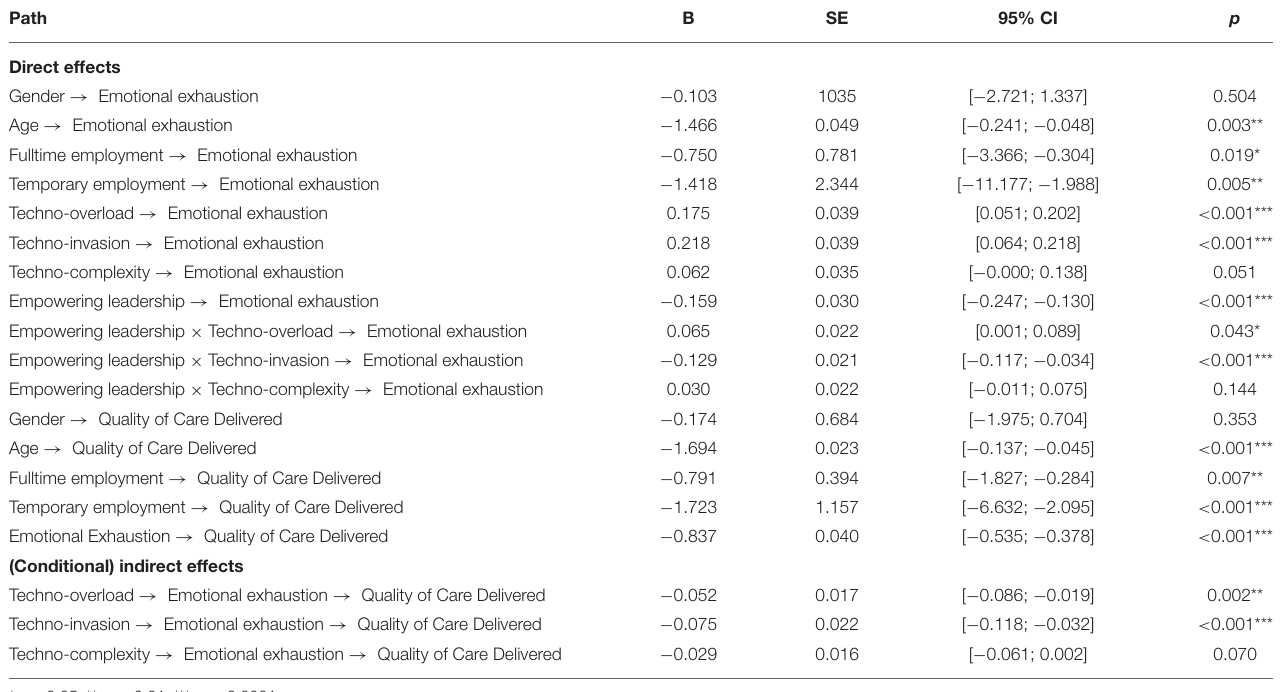
TABLE 3 | Structural paths ( N = 301).